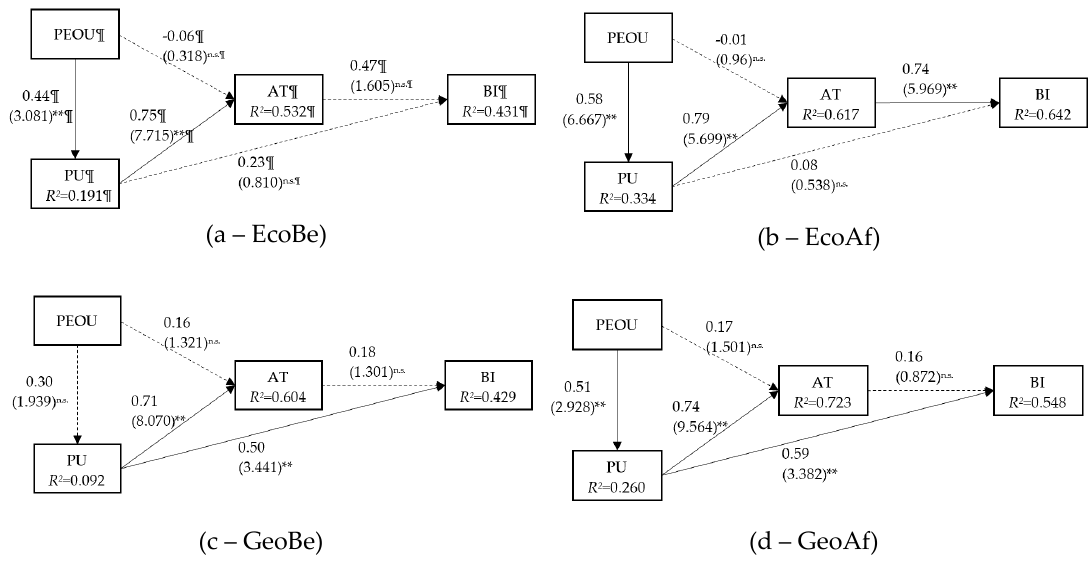
Figure 6. ( a ) Results of structural model analysis for economic students at the beginning; ( b ) Results of structural model analysis for economic students at the end; ( c ) Results of structural model analysis for geography students at the beginning; ( d ) Results of structural model analysis for geography students at the end.